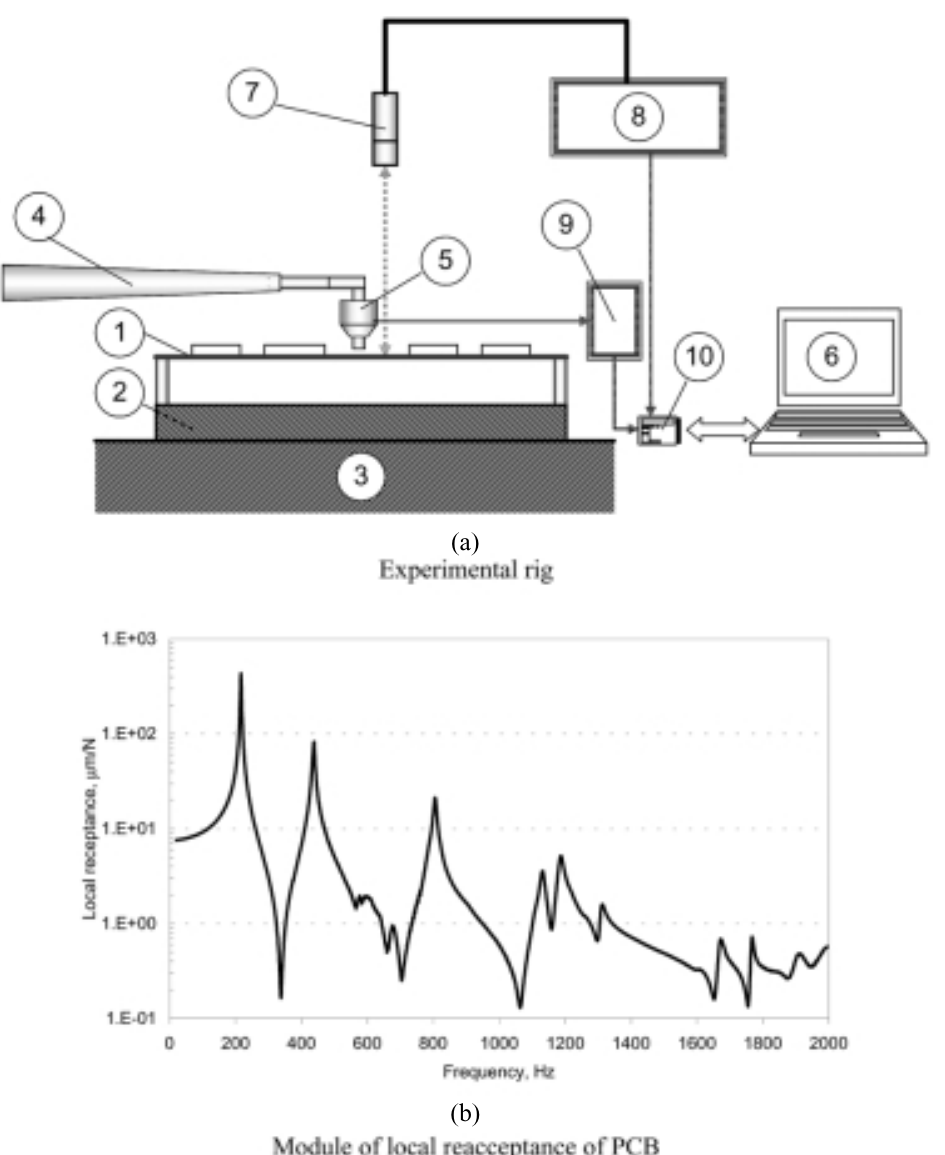
Fig. 3. Schematics of experimental rig and typical module of complex receptance. a) Experimental rig; b) Module of local reacceptance of